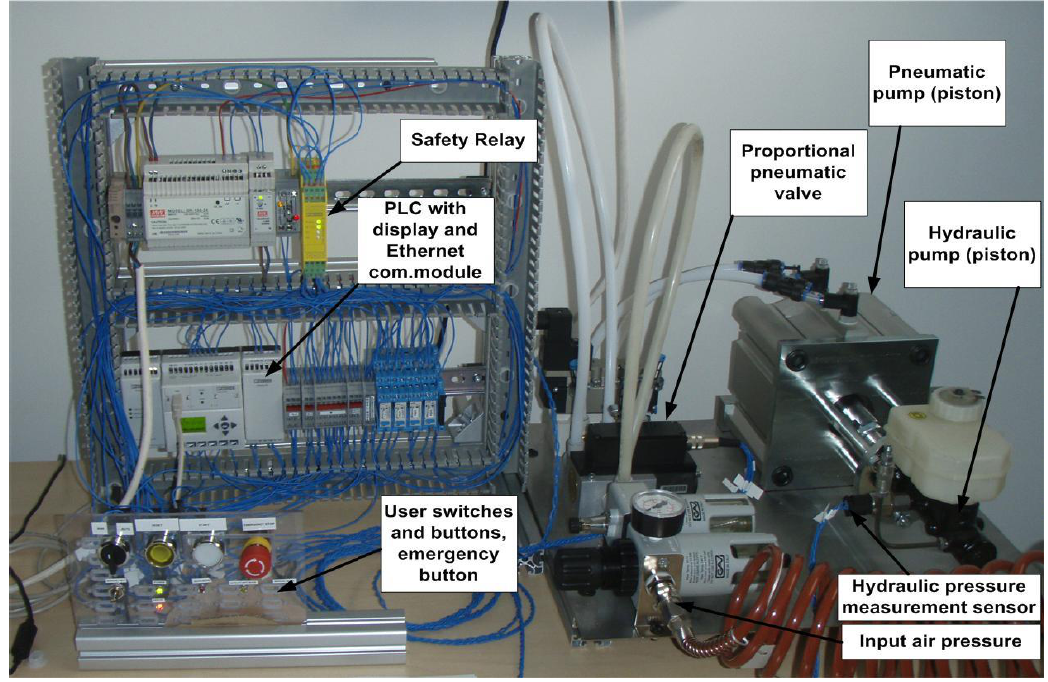
Figure 3. The photo of the functional prototype of the pneumatic – hydraulic pulse system.